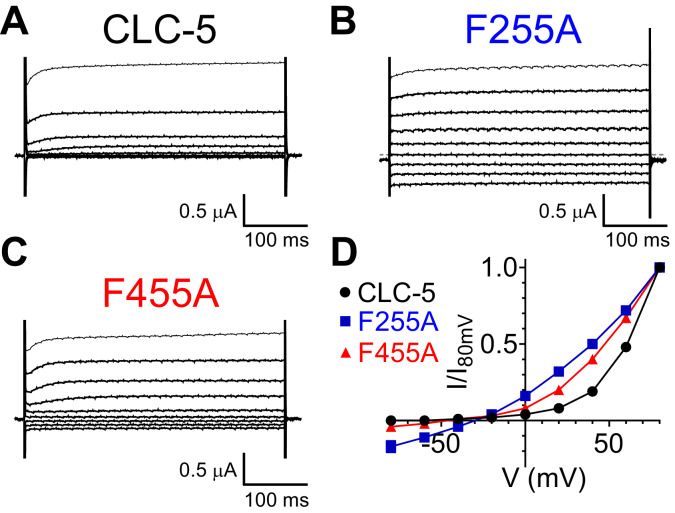
Phecen (F455) and Pheex (F255) regulate the voltage dependence of the CLC-5 exchanger.(A–C) TEVC current recordings of CLC-5 WT (A), F255A (B) and F455A (C). For voltage clamp protocol see Methods section. (D) Normalized steady state I-V relationship for CLC-5 WT (black circles, N = 25), F255A (blue squares, N = 10) and F455A (red triangles, N = 22). Values are reported as mean ± S.E.M, error bars are not shown where they are smaller than the symbol size. The raw data for the traces shown is available in Figure 5—figure supplement 2—source data 1.Figure 5—figure supplement 2—source data 1.Individual normalized data points.